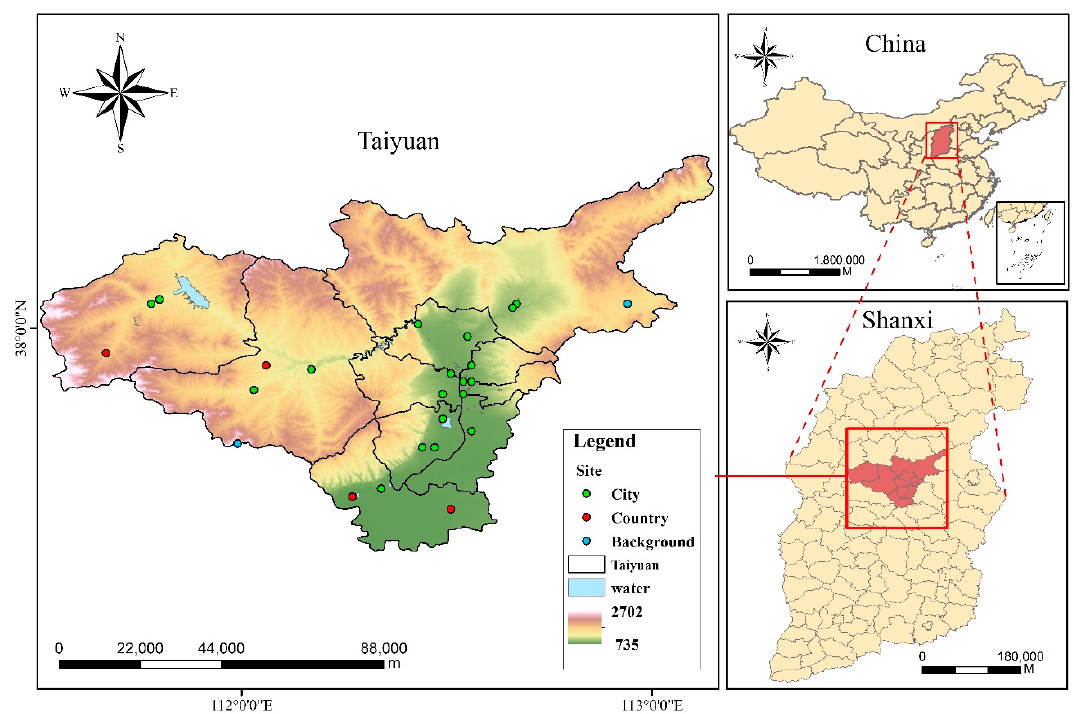
Figure 1. Location of the study area.